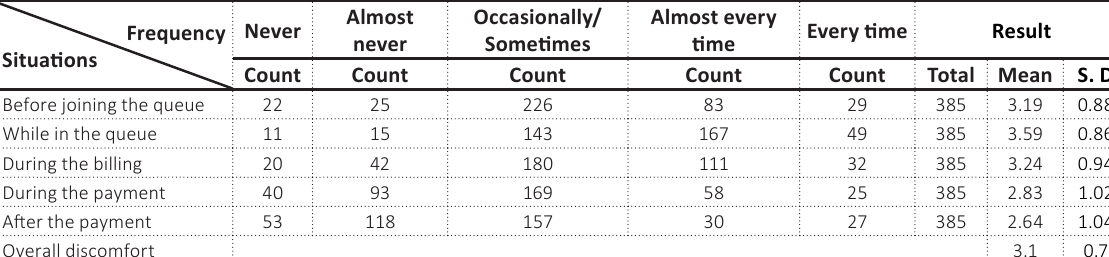
Table 2. Mean discomfort at different stages of